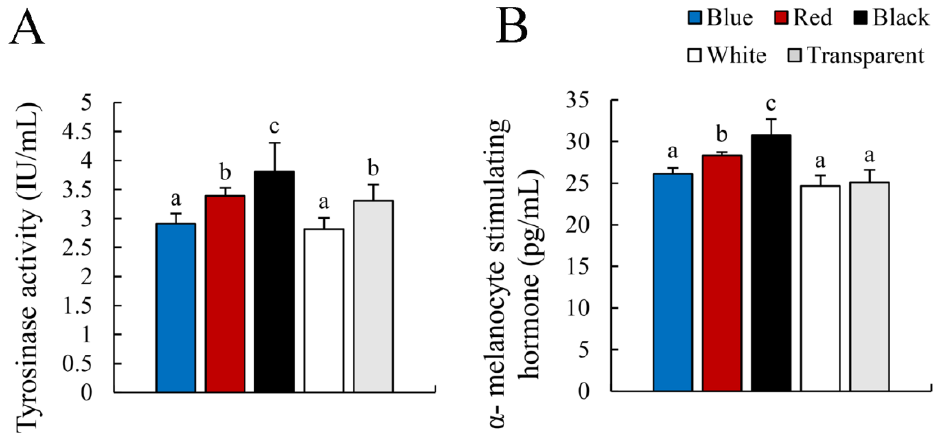
Figure 4. Tyrosinase activity and α -MSH levels in serum. ( A ): Tyrosinase activity; ( B ): α -melanocyte stimulating hormone. Values are means ± standard error for ten replicates. Significant differences for means within experimental groups are indicated with different lowercase letters ( p < 0.05, n = 9).